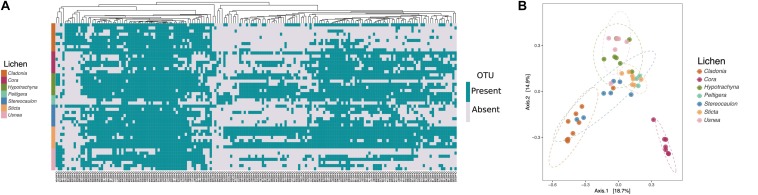
Members of the same lichen genus share similar microbial communities. Data based on the 177 OTUs with significant differences in abundance found by ALDEx2. (A) Prevalence matrix based on OTU presence/absence. A WPGMA hierarchical clustering method was used to group the significantly different OTUs (shown on bottom) on a dendrogram based on a Bray-Curtis dissimilarity matrix. Each row represents the presence/absence of OTUs in a given lichen sample (shown left). (B) Principal Coordinates Analysis (PCoA) based on the Bray-Curtis index shows microbiomes of lichens Cora and Cladonia differentiated from other lichens.